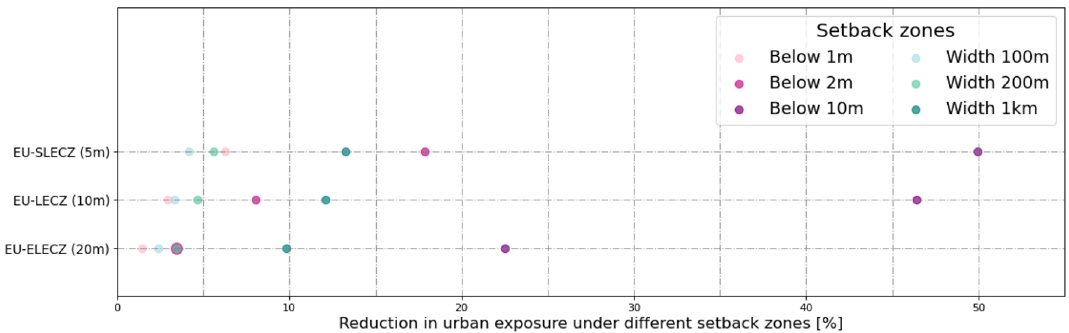
Figure 9. Sensitivity analysis of different coastal definitions on the results for Europe using three different coastal floodplain definitions (hydrologically connected to the sea; below 20 m (ELECZ), 10 m (LECZ), and 5 m (SLECZ)).